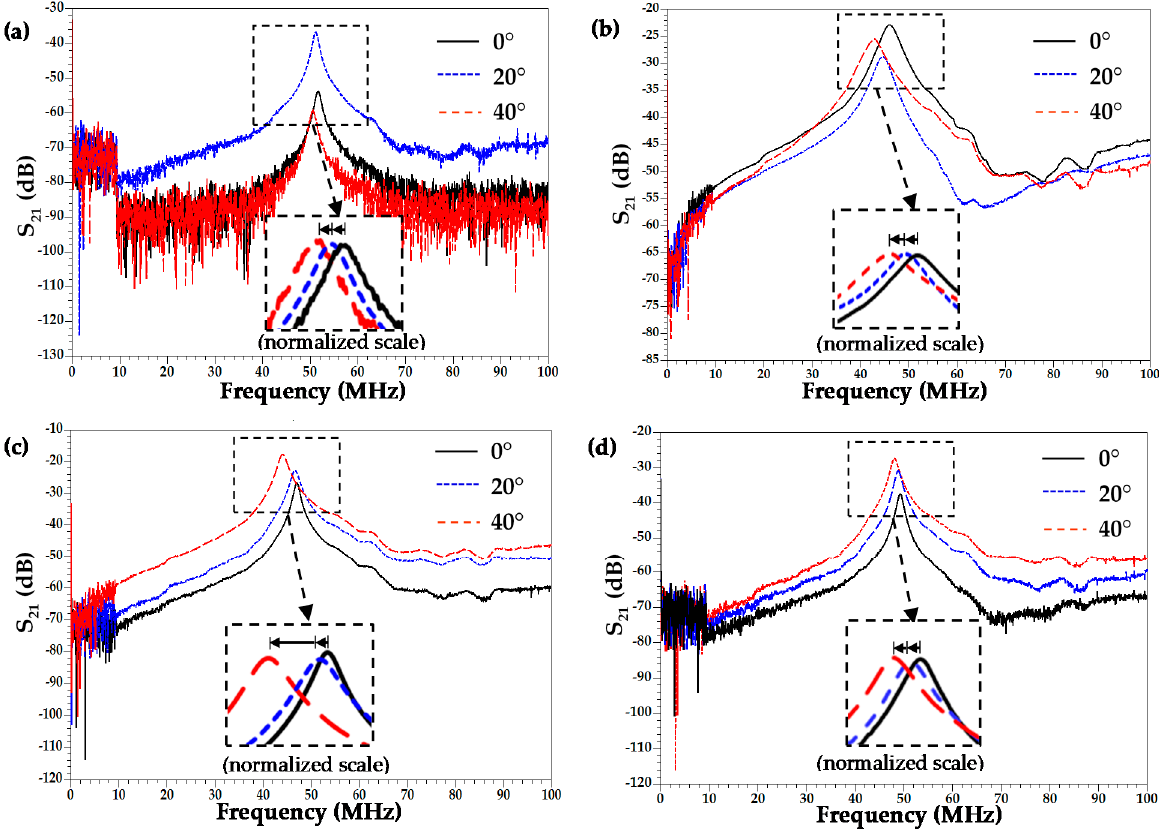
Figure 10. Frequency response representation from 10 kHz–100 MHz at different angles: ( a ) PVDF/PZT; ( b ) PVDF/PZT/CNTs; ( c ) PVDF/CNTs; ( d ) PVDF/CCTO. The zoomed in box shows the peak shift in normalized frequency response when the SAW sensor was under bending in three different angles. Table 4. Frequency shift data for a different type of fillers in PVDF